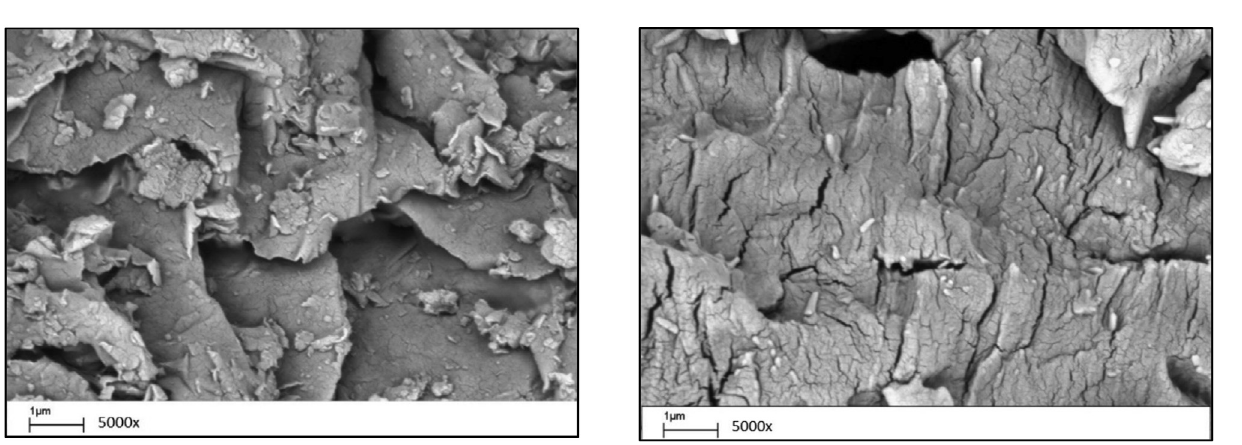
Figure 1. SEM image of MMT Figure 2. SEM image of SMMT